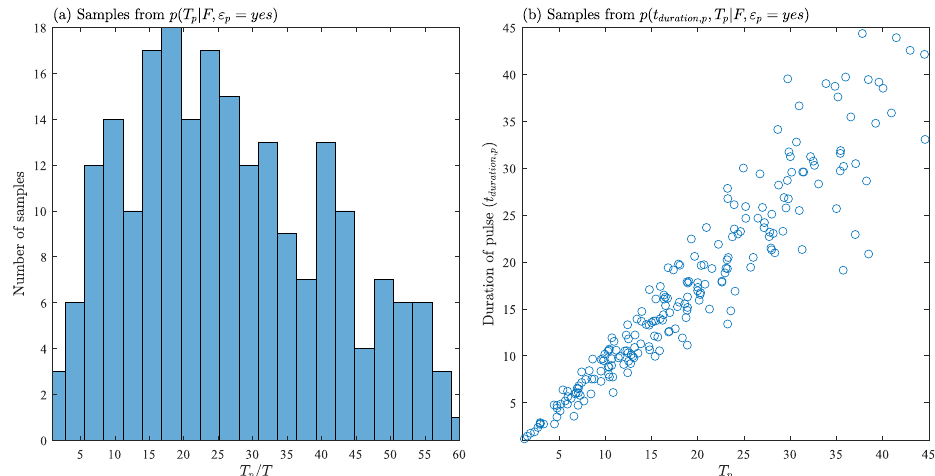
Figure 15. ( a ) Samples for ratio of pulse period to fundamental period of structure conditional on failure and ε p = yes (i.e., samples from p ( T p | F , ε p = yes ) ). ( b ) Samples for pulse period and pulse duration conditional on failure and ε p = yes (i.e., samples from p ( T p , t duration , p | F , ε p = yes ) ). Both plots are for the chevron-braced frame.